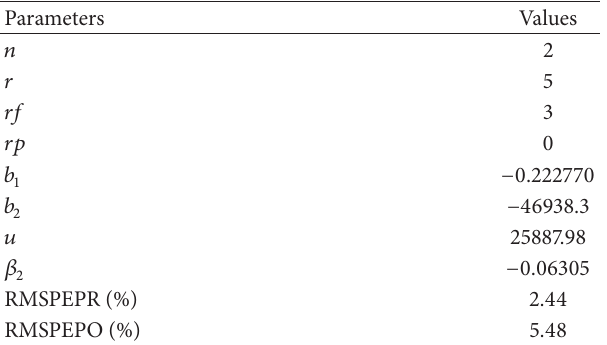
Table 5: The values of parameters 𝑛 , 𝑟 , 𝑟𝑓 , and 𝑟𝑝 in (21), the estimates of model parameters 𝑏 1 , 𝑏 2 , 𝑢 in (23) and the optimized parameter 𝛽 2 in (40), and the values of RMSPEPR and RMSPEPO in (38) and (39).